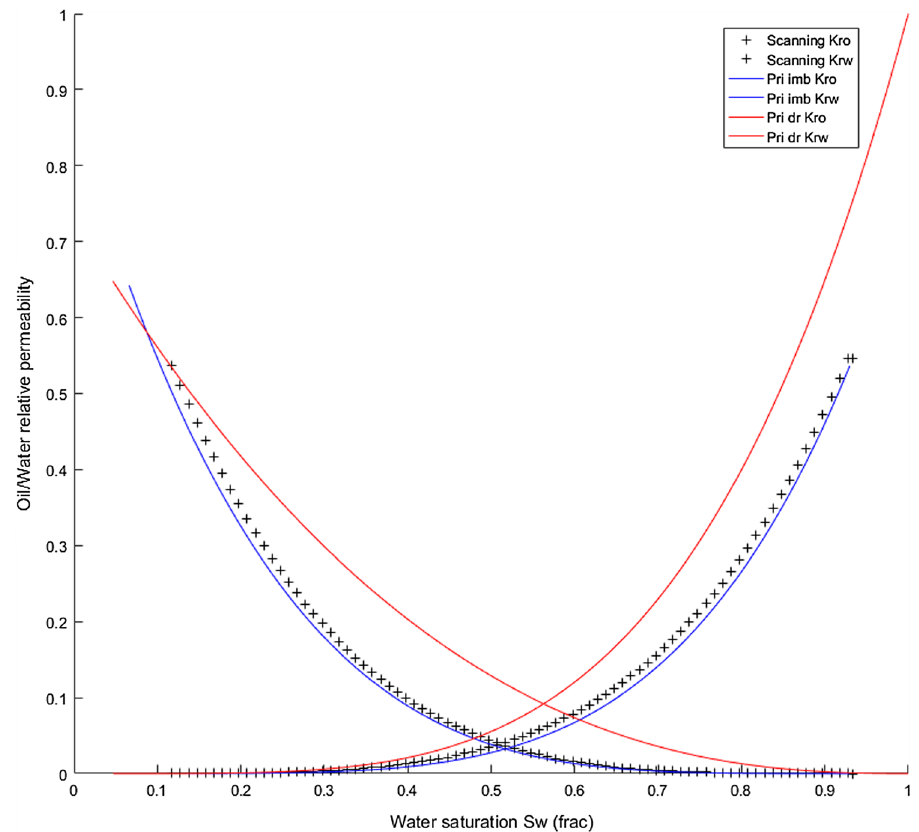
Fig. 13 Bounding drainage/ imbibition curve and scanning curve for rock type 1(Masalmeh Model, linear-type S oi / S or rela-